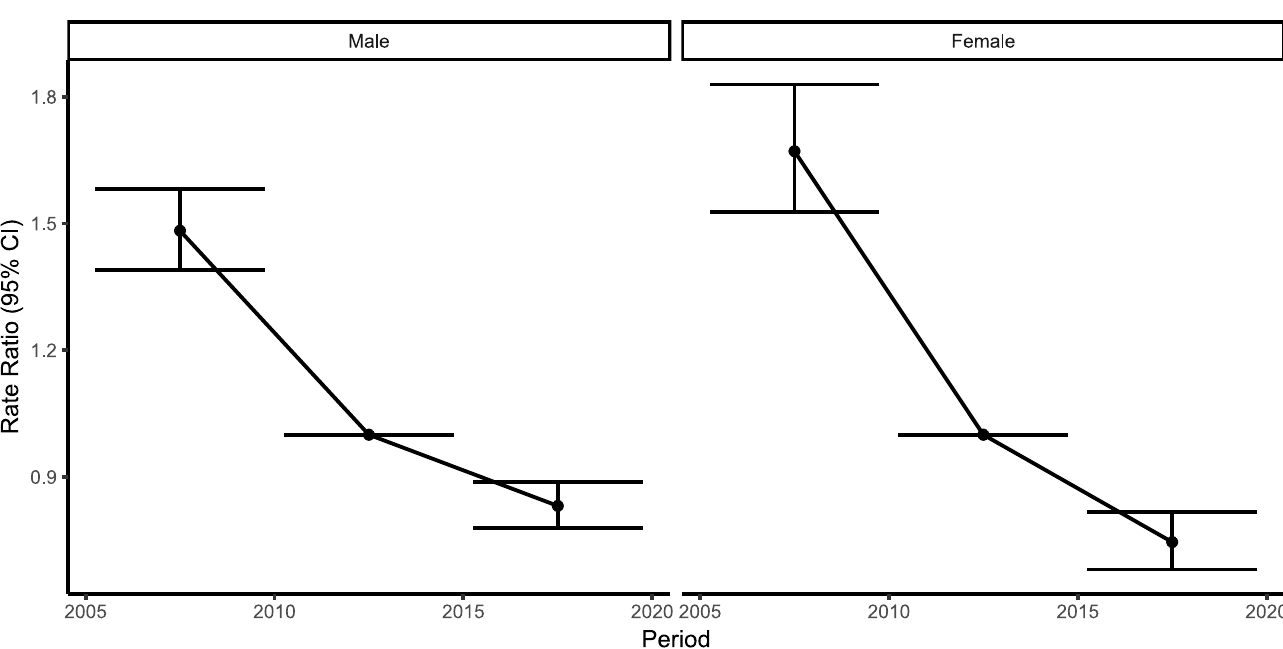
Figure 2. Age effects, Male ( left ) and Female ( right ). Longitudinal age curves are estimated via the age – period – cohort model and indicate the expected age-specific rate of ACS mortality per 100,000 in a reference cohort adjusted for period effects (marked by *).